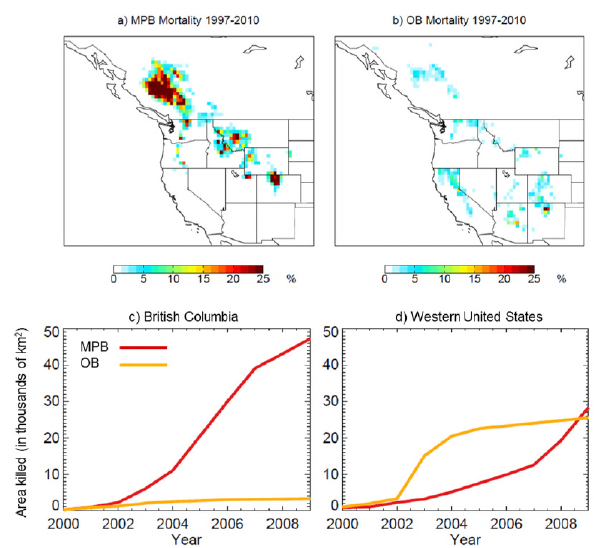
Fig. 2. Cumulative percent of area killed in 2010 in BC and the western US due to (a) mountain pine beetle (MPB) and (b) other beetles (OB) (color bar saturated at 25%), and cumulative beetle- induced tree mortality over time in (c) BC and (d) western US caused by the mountain pine beetle and other